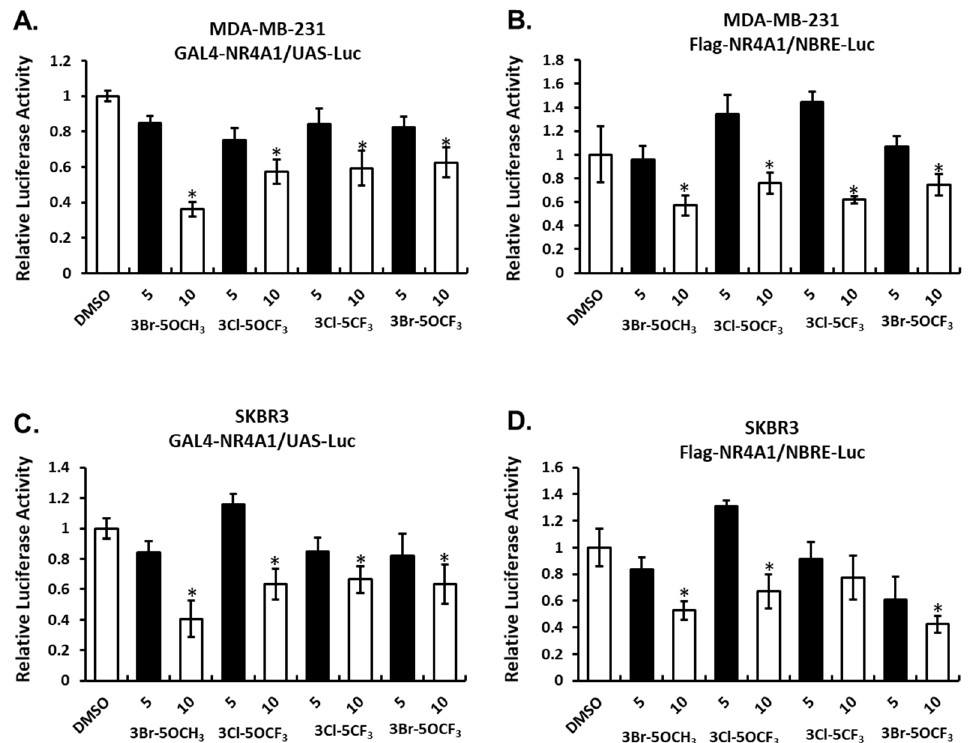
Figure 2. Compound-mediated NR4A1-dependent transactivation in breast cancer cells. MDA-MB- 231 cells were transfected with GAL4-NR4A1/UAS-luc ( A ) or Flag NR4A1/NBRE-luc ( B ) constructs, treated with CDIM compounds and luciferase activity determined, as outlined in the Materials and Methods section. CDIM/NR4A1 antagonist-mediated luciferase activity in SKBR3 cells transfected with GAL4-NR4A1/UAS-luc ( C ) and Flag NR4A1/NRBE-luc ( D ) was determined, as described for MDA-MB-231 cells. Results are expressed as means ± SD for at least three replicate determinations for each concentration, and significant ( p < 0.05) inhibition is indicated (*).